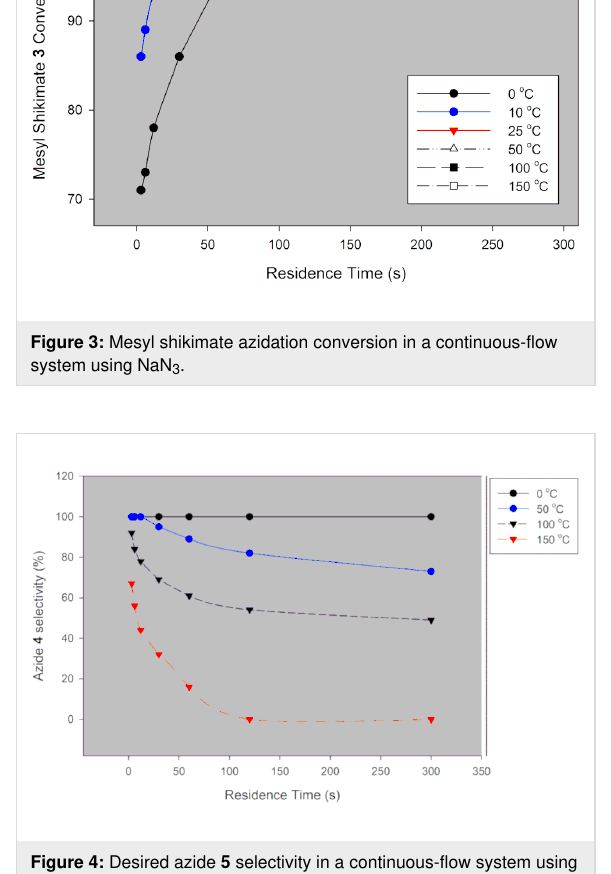
Figure 4: Desired azide 5 selectivity in a continuous-flow system using NaN 3 .